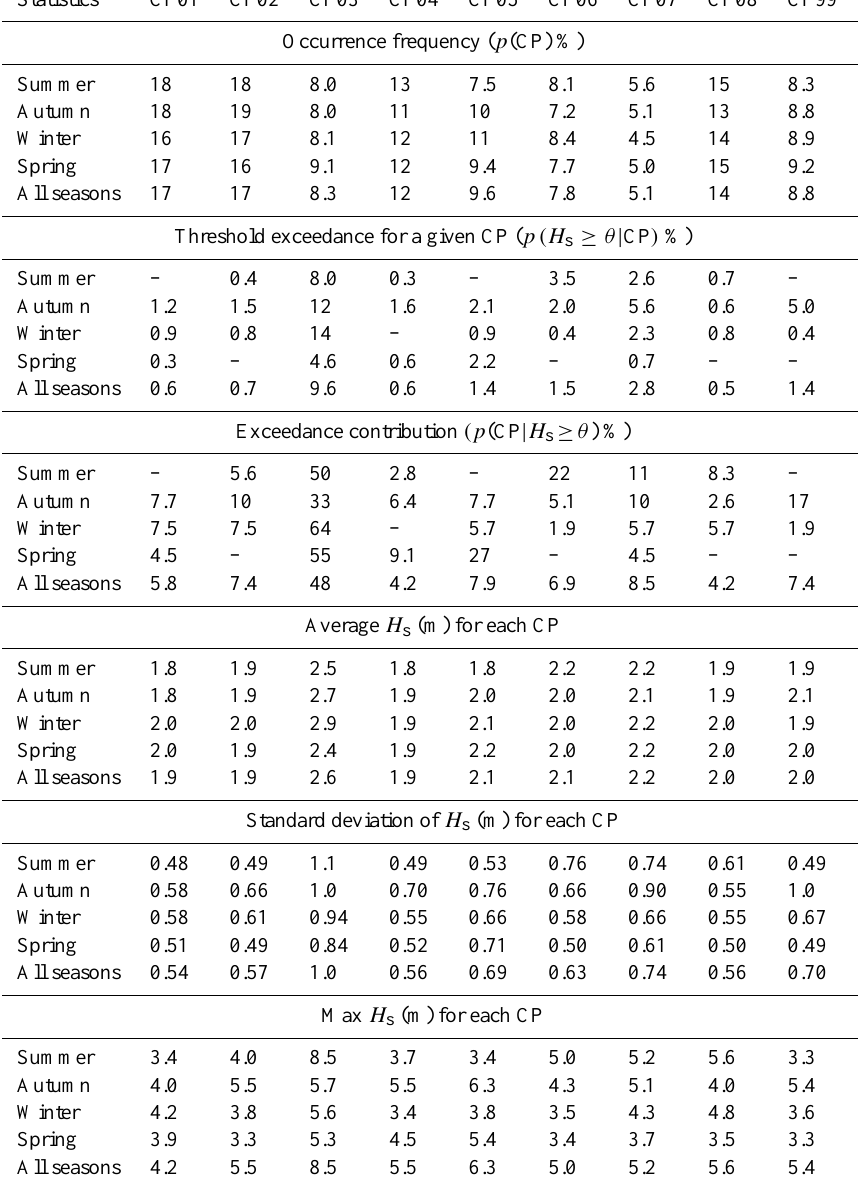
Table 2. CP occurrence frequencies and wave height statistics associated with each CP. Statistics were calculated for the period 1992–2009.